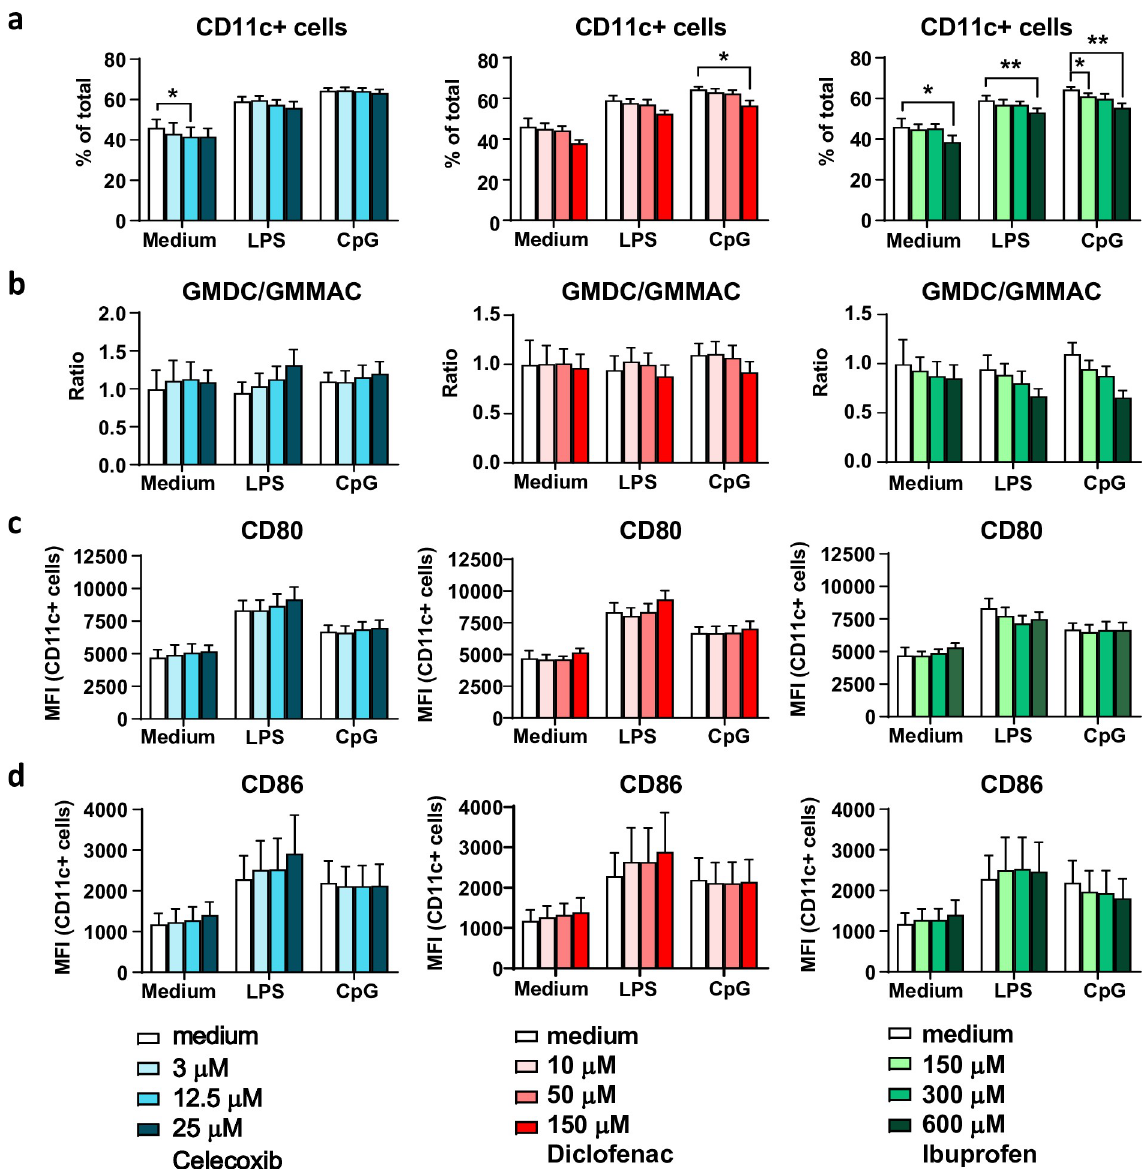
Fig 3. NSAIDs do not alter TLR-induced maturation marker expression. (a-d) mBMDCs were first pretreated with NSAIDs for 6 hr, followed by a 2.5 hr TLR stimulation with LPS, CpG, or R848. After overnight rest in fresh medium, composition of the mBMDC culture (a, b) and maturation marker expression (c, d) were analyzed using flow cytometry (n = 4). Results are shown as means with SEM. (a) Percentage CD11c+ cells in BMDC culture. (b) GM-DC/GM-MAC ratio within CD11c+ population. (c) Mean Fluorescent Intensity (MFI) ± SEM of CD80 and (d) CD86 in CD11c+ population. Statistical significance was calculated using a one-way ANOVA with Dunnett’s multiple comparison test, medium versus rest.